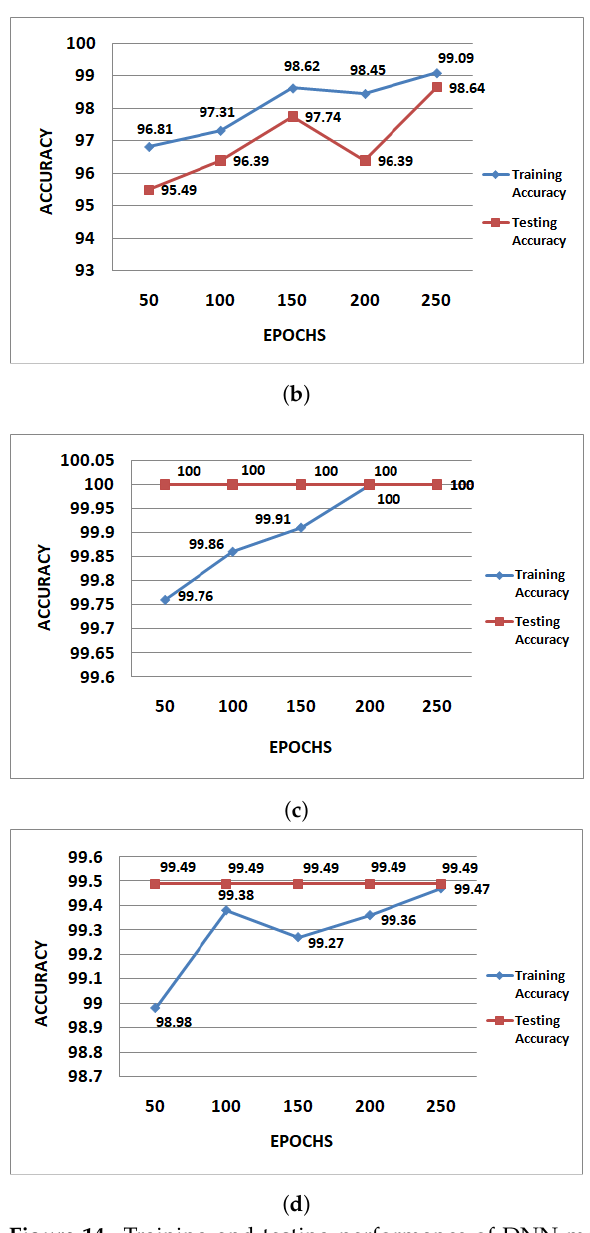
Figure 14. Training and testing performance of DNN model with respect to various number of epochs. ( a ) Noise level: 10 to 50 (Dataset-1). ( b ) THD level: 10 to 50 (Dataset-2). ( c ) THD level: 50, noise level: 10 to 40 (Dataset-3). ( d ) Noise level: 5 to 20